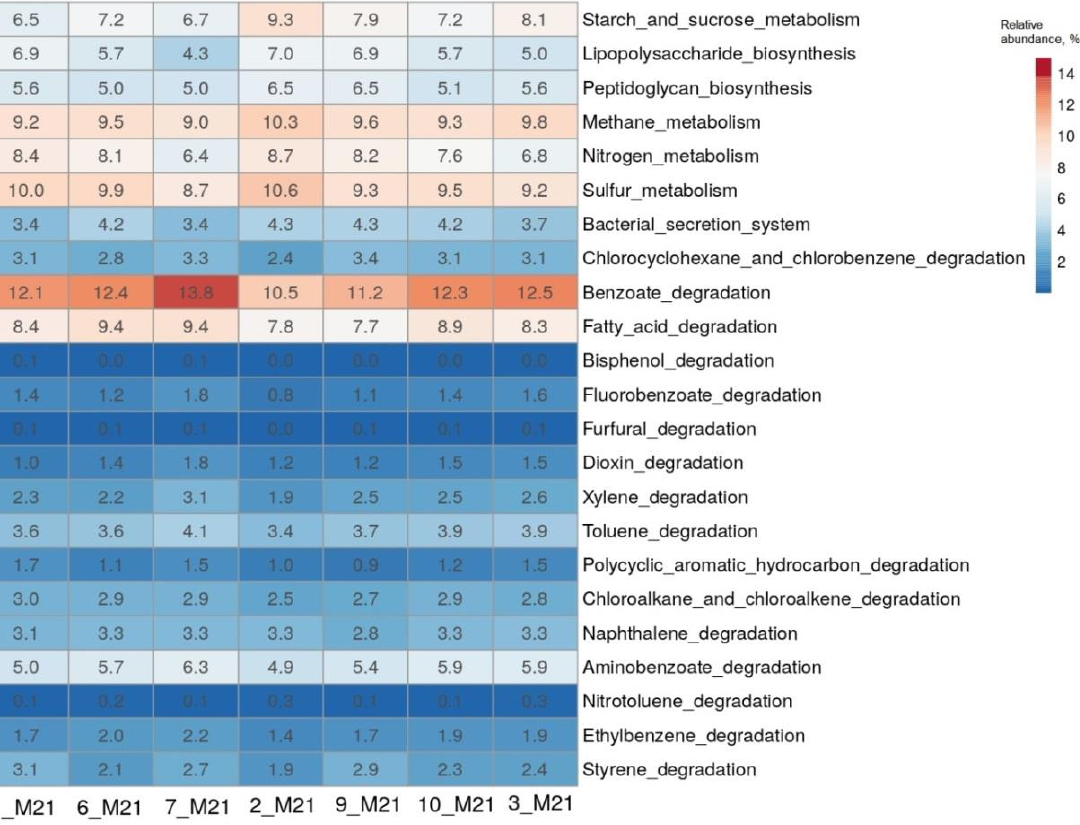
Figure 4. The heatmap showing the predicted functional profiles of studied microbial communities based on the KEGG Database.